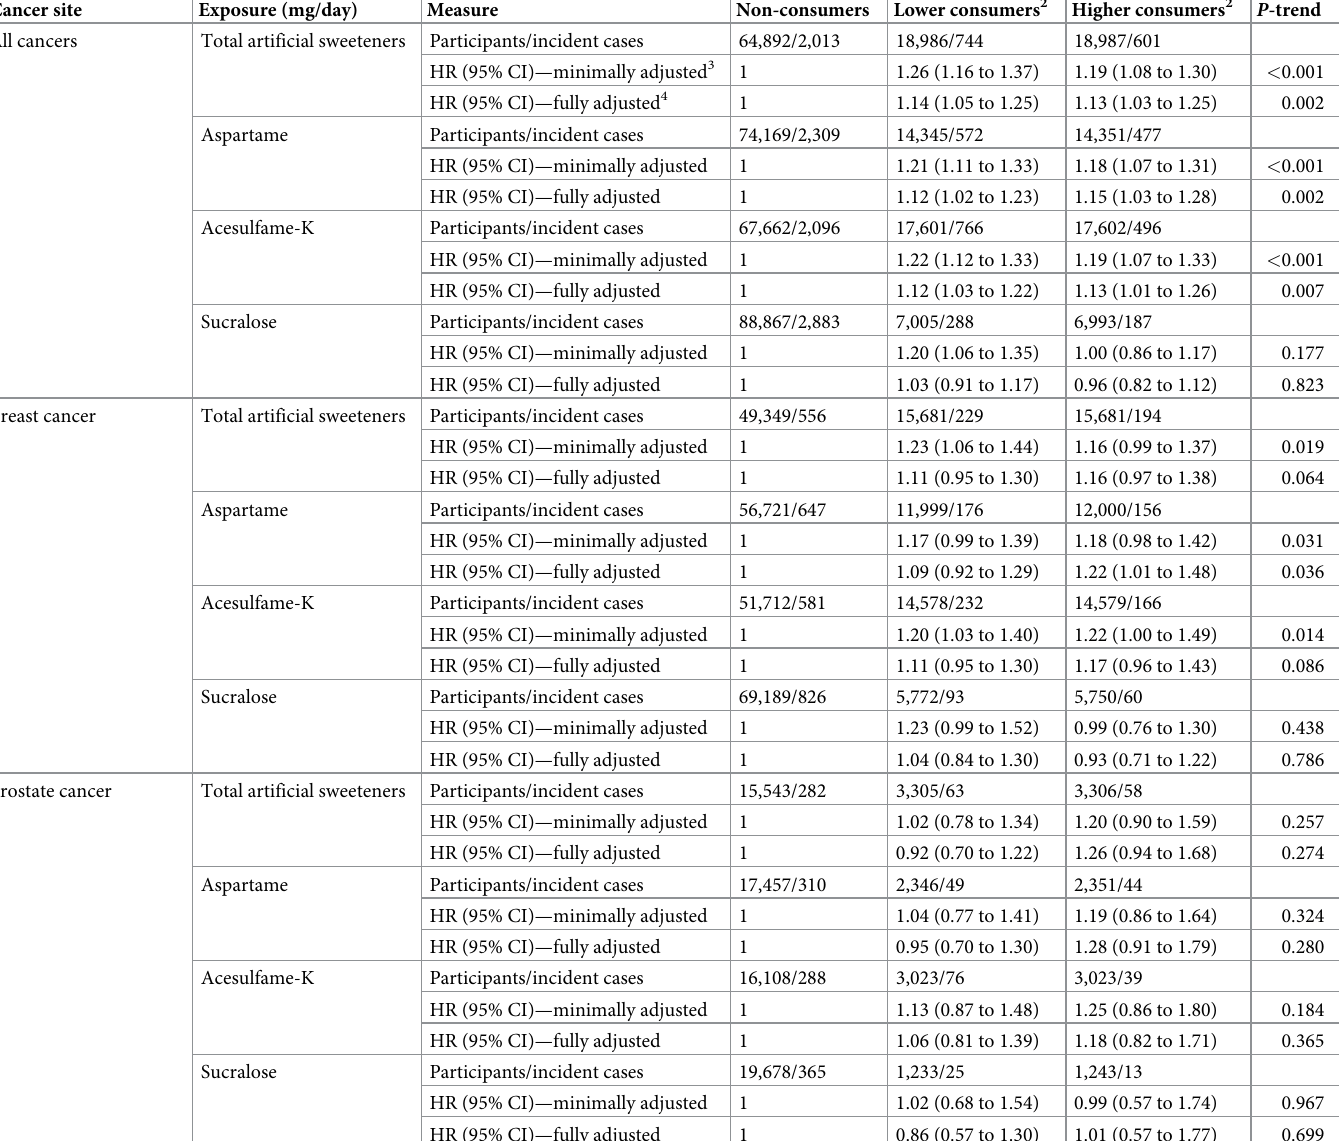
Table 2. Association between total artificial sweetener, aspartame, acesulfame-K, and sucralose intakes (mg/day) and cancer risk, NutriNet-Sante´ cohort, France, 2009–2021 ( n = 102,865) 1 . Cancer